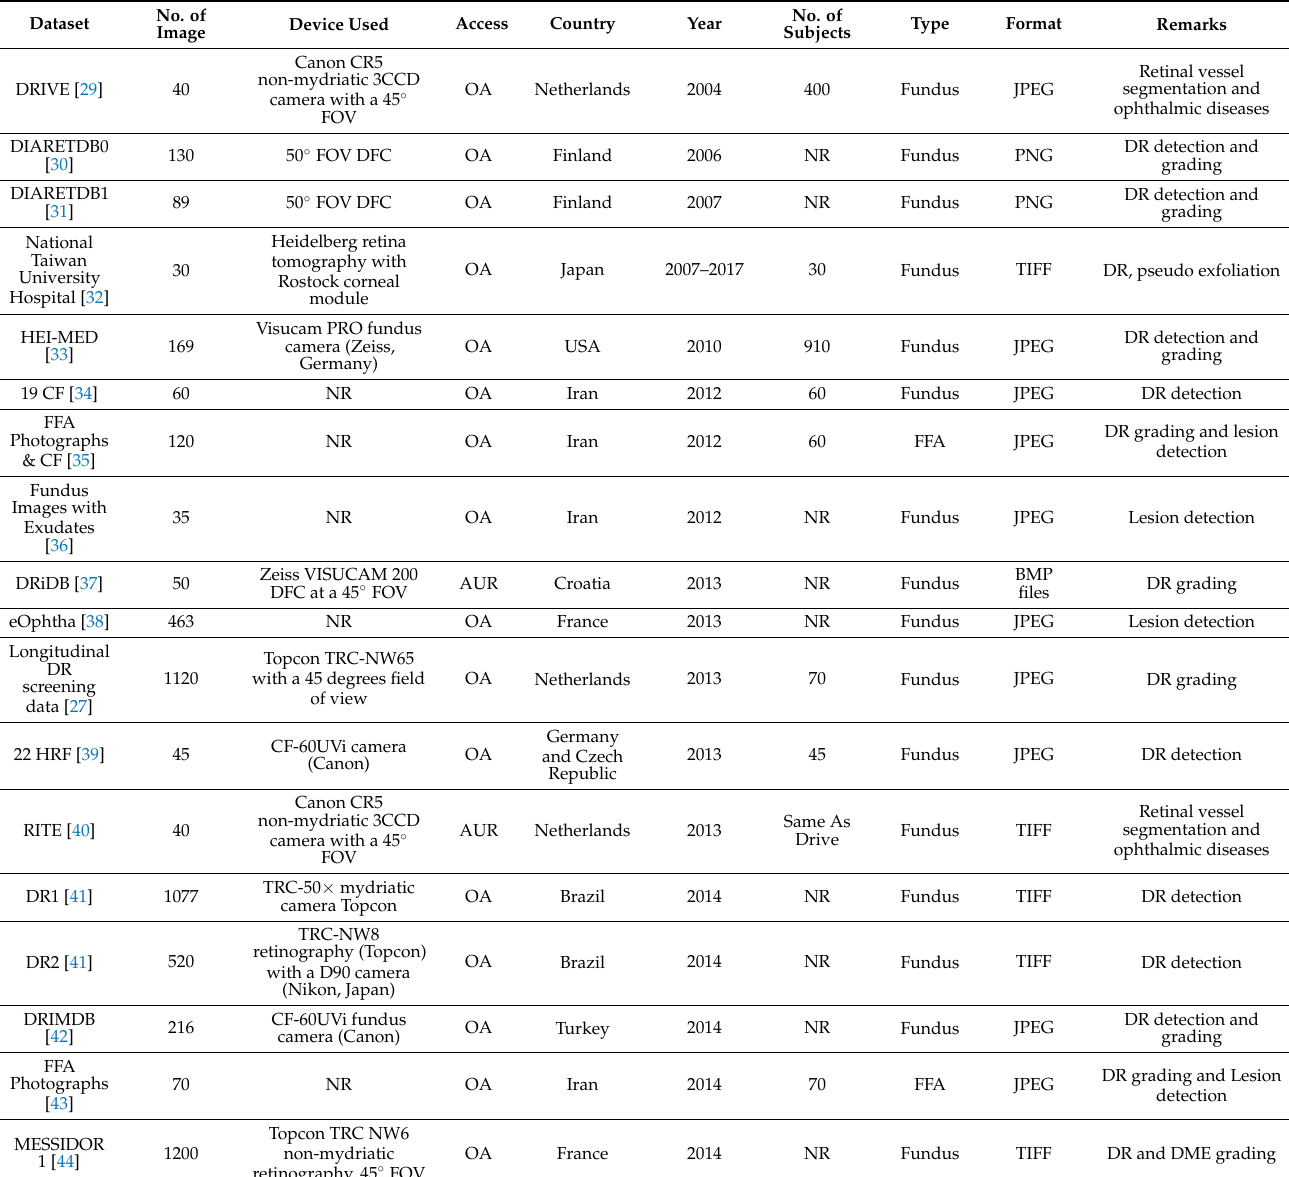
Table 1. Datasets for DR detection, grading and segmentation and their respective